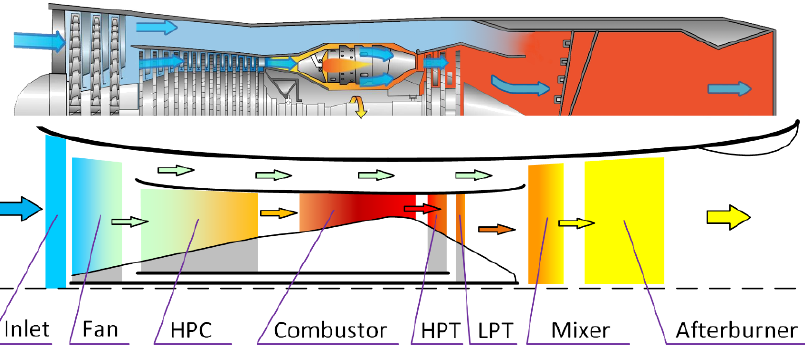
Figure 7. The configuration of the turbofan engine. Table 1. Definition of engine’s measurable section numbers.